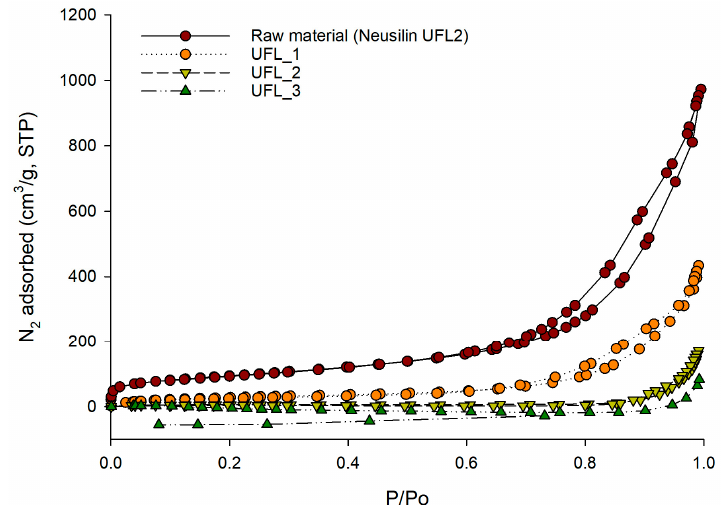
Figure 3. Nitrogen adsorption/desorption isotherms for raw Neusilin ® UFL2 and orlistat-loaded Neusilin ® UFL2 at three different drug loading ratio.